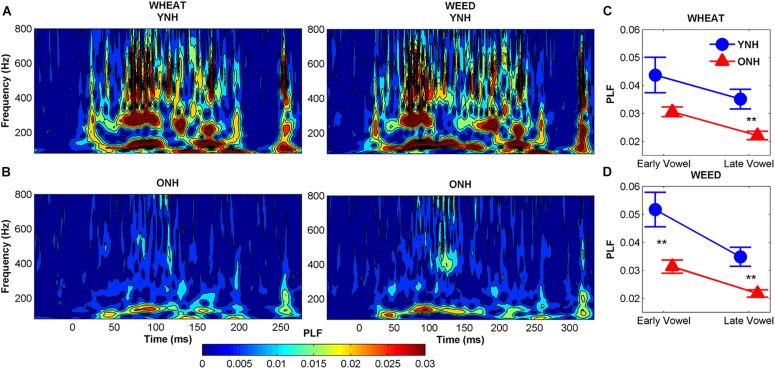
Average phase-locking factor (PLF) to the temporal envelope of WHEAT (left column) and WEED (right column) stimuli represented in the time-frequency domain, with hotter (red) colors indicating increased phase locking in younger normal-hearing (YNH) (A) and older normal-hearing (ONH) (B) participants. Right panel: Average PLF values to the 138-Hz fundamental frequency in the early and late time regions corresponding to the vowel /i/ of WHEAT (C) and WEED (D). ONH participants demonstrated reduced phase locking compared to YNH participants. For both participant groups, phase locking declined from the early vowel region to the late vowel region to both stimuli. Error bars: ± 1 standard error. ∗∗p < 0.01.